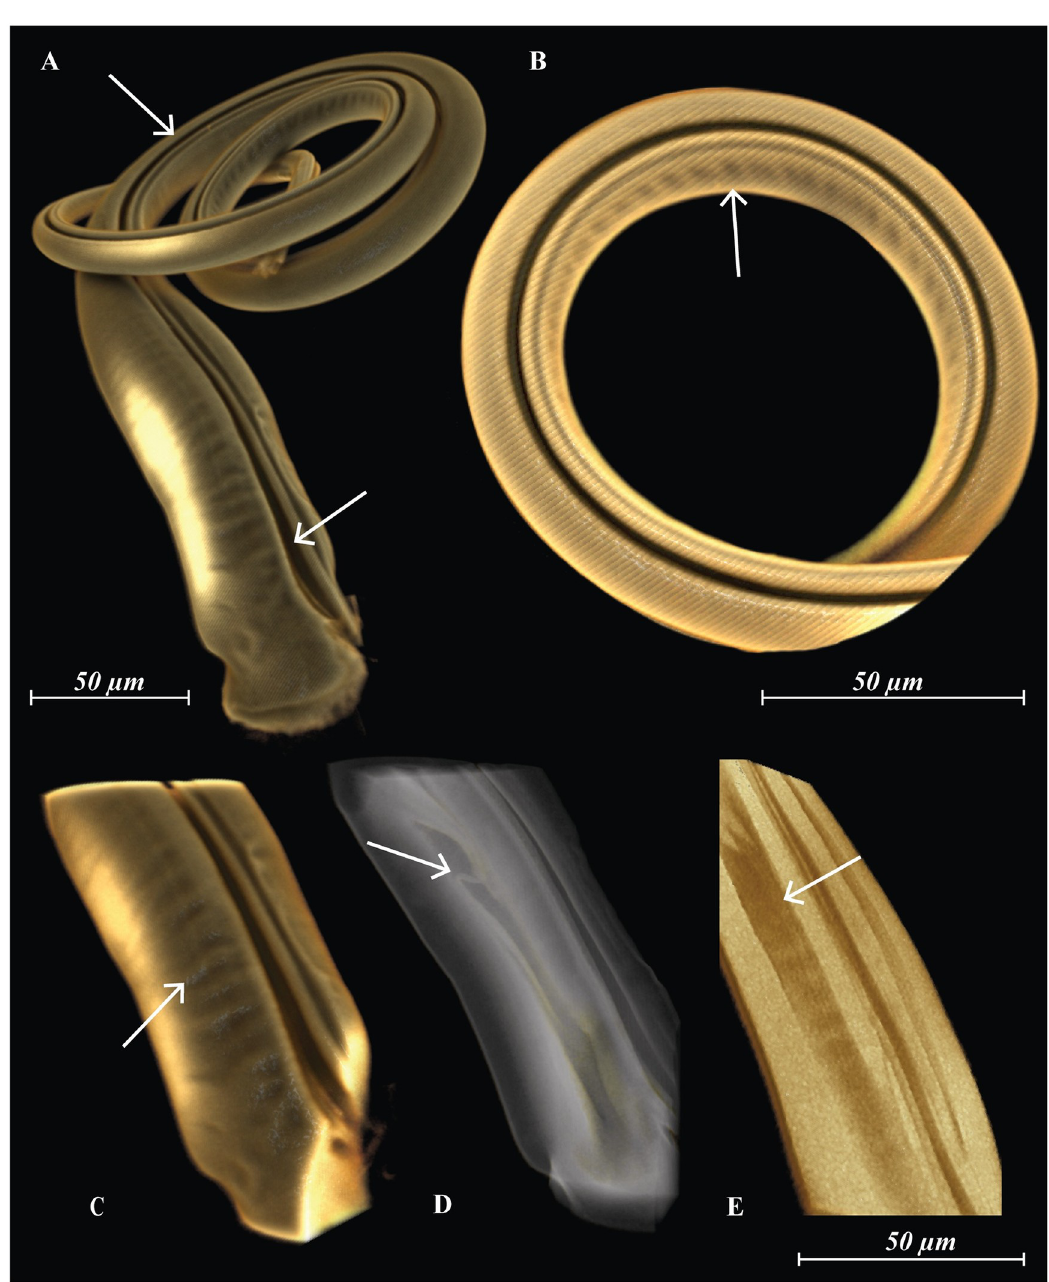
Fig 3. Megalolaelaps colossus male spermatodactyl based on CLSM. (a) external groove (arrows) (b) detail of the distal annuli-like structures (arrow) (c) detail of the proximal annuli-like structures (arrow) (d) detail of the unidentified structure unfolded (arrow) (e) detail of the unidentified structure folded